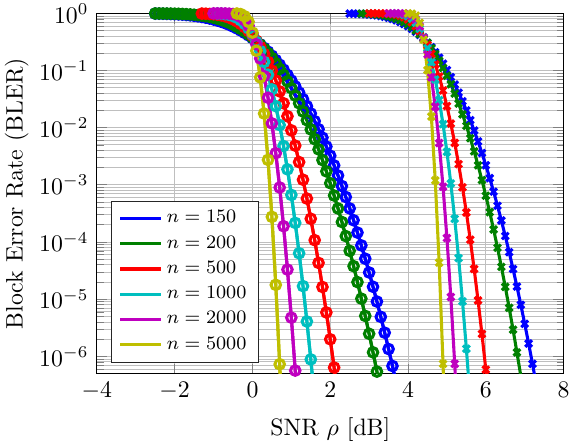
Fig. 3 Non‑asymptotic error performance of ( n , M , ǫ , ρ ) codes in the finite‑blocklength regime. Round and cross markers correspond to code rates R of 0.5 and 0.95, respectively